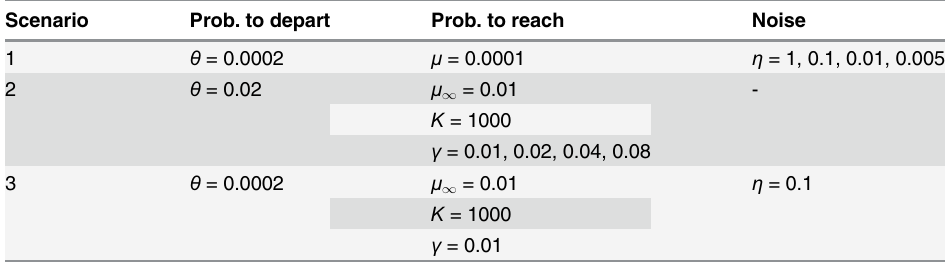
Table 1. Model parameters for the three scenarios. Columns from left to right indicate the parameters related to the probability to depart from a receiver, the probability to reach a receiver and the probability of detecting a fish due to environmental/instrumental noise.